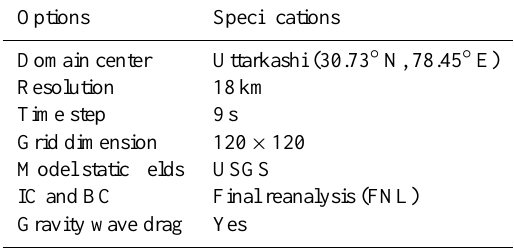
Table 1. Different model configuration options used in the control as well as sensitivity experiments.